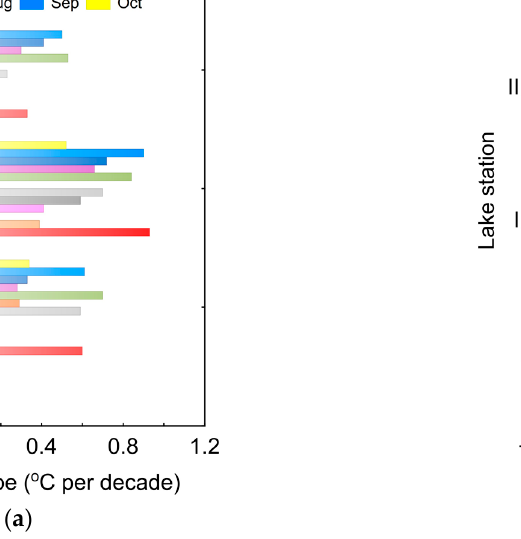
Figure 5. Changes in mean monthly lake water temperatures: ( a ) Rate of changes in °C per decade and ( b ) significance of the changes (solid line—significance level of 0.05, dashed line—significance level of 0.01).